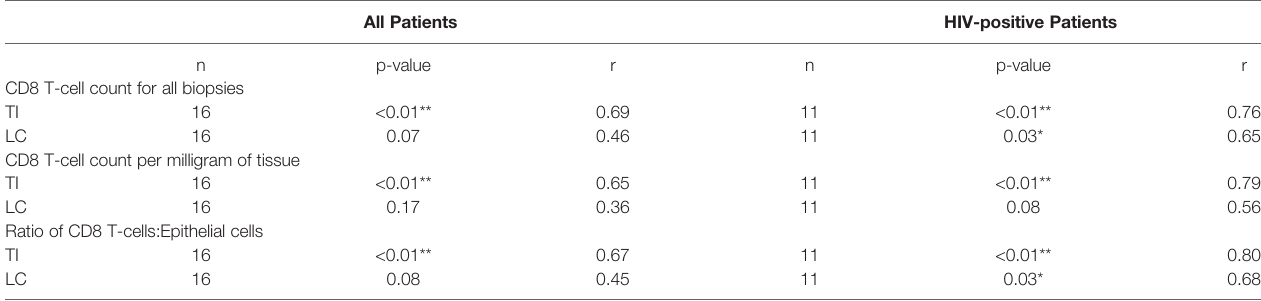
TABLE 3 | Relationship between systemic CD8 T-cell concentration measured in peripheral blood and measured gastrointestinal lymphocyte numbers, for all study groups combined, and for HIV-positive study participants only. All